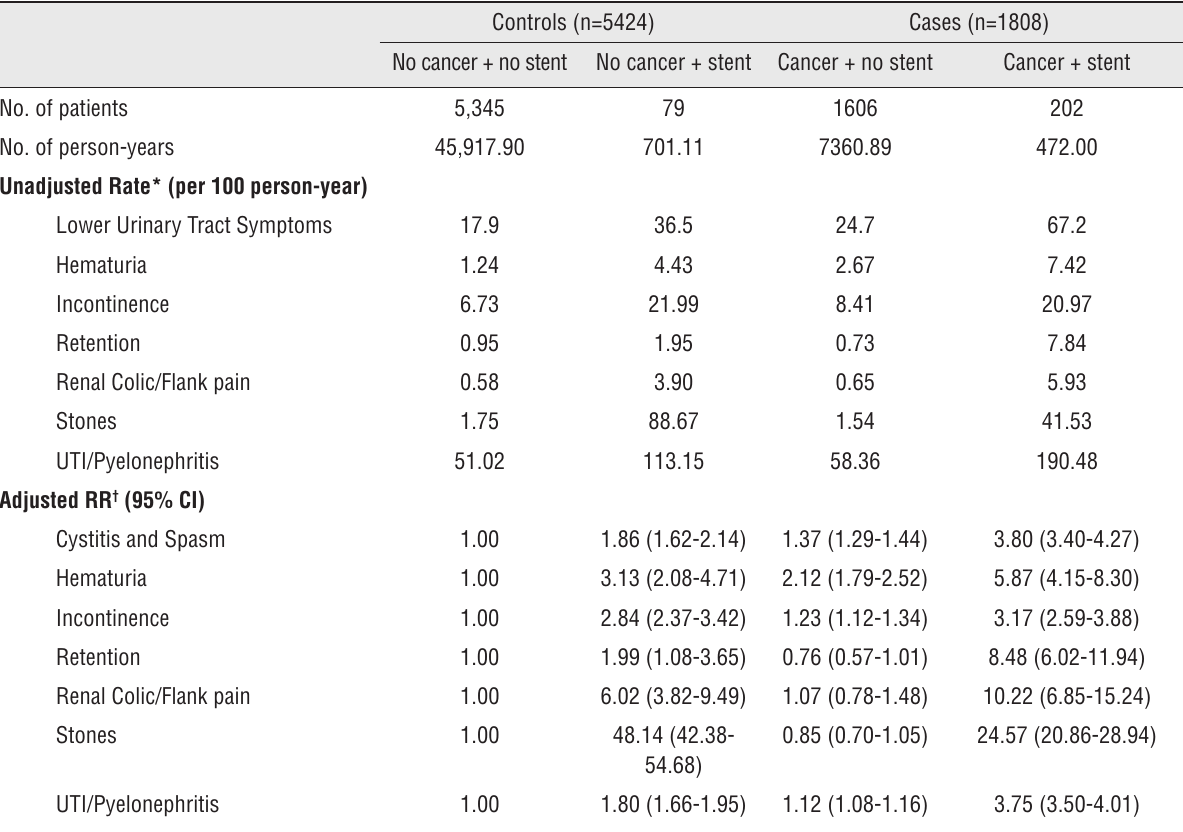
Table 3 - Rate and risk of UAE among cervical cancer cases and